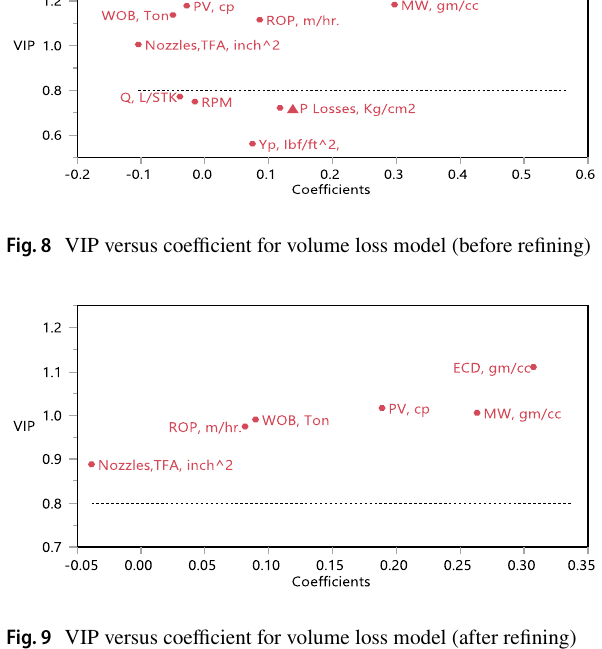
Fig. 9 VIP versus coefficient for volume loss model (after